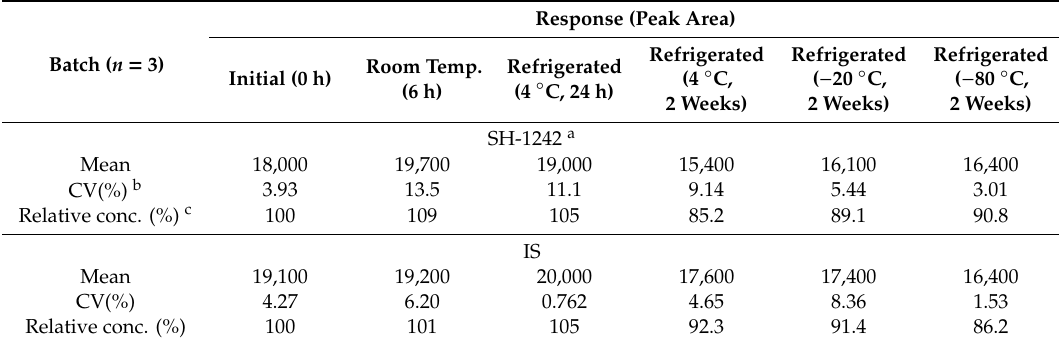
Table 5. Stability of SH-1242 and IS in stock solutions under typical storage conditions.